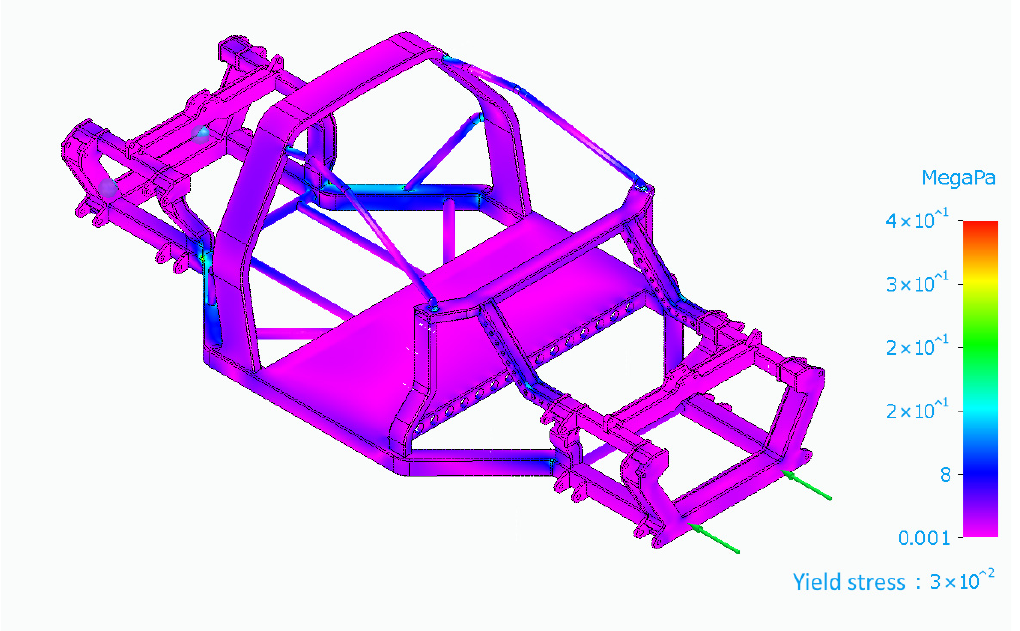
Figure 25. FEM Analysis simulating Euro NCAP frontal impact at 50 Kph.